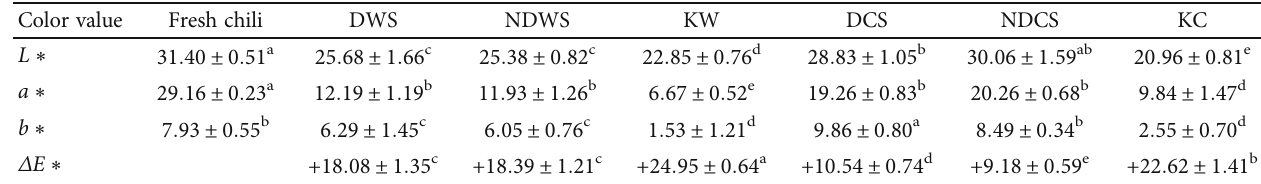
Table 3: The color value of chili powder.